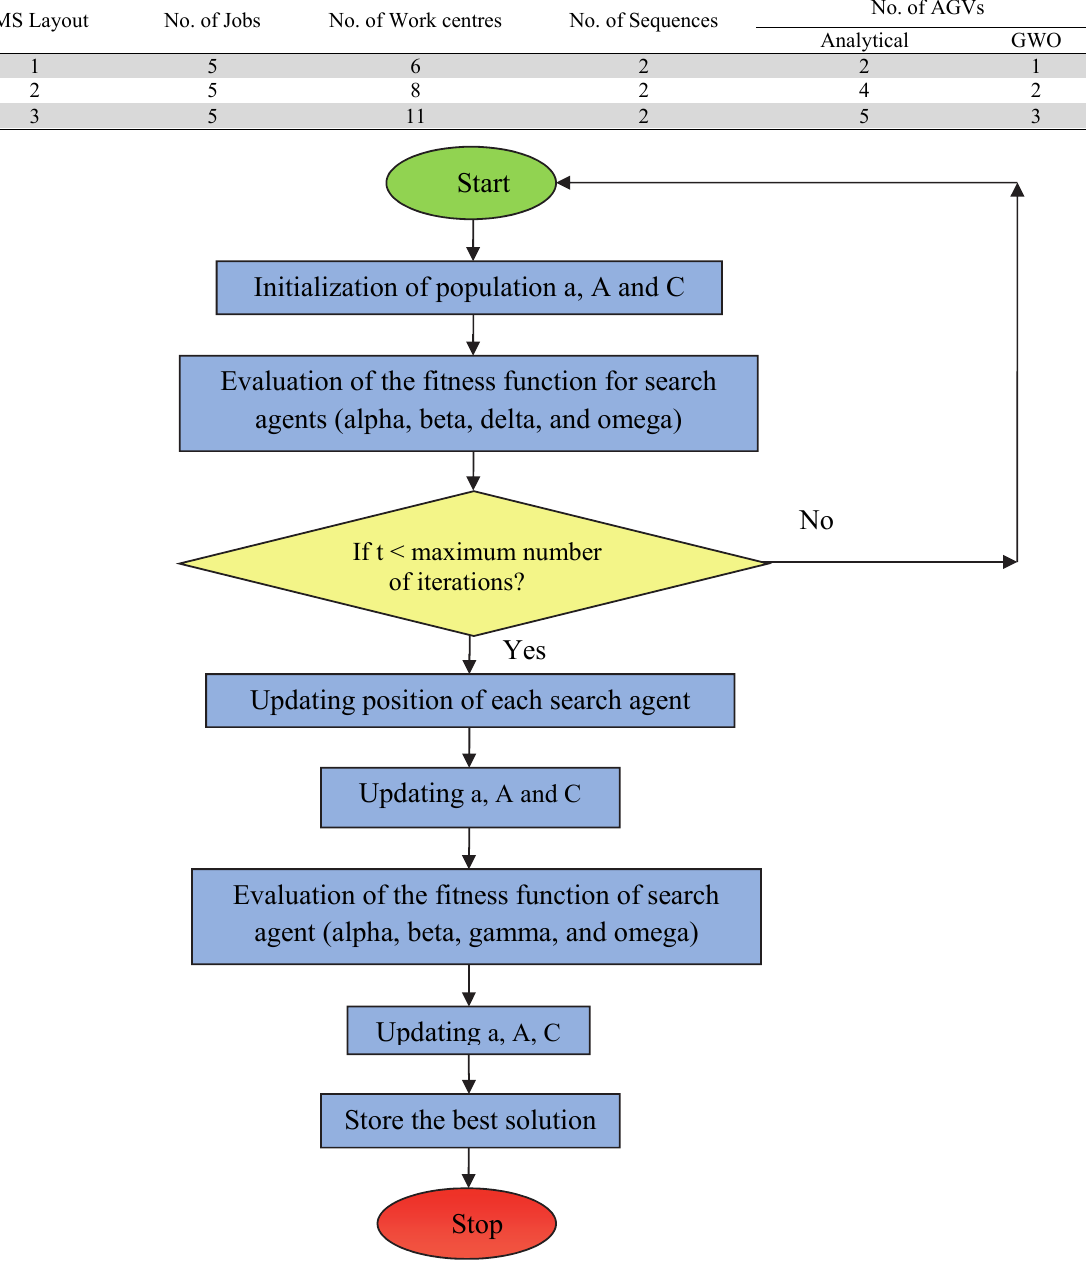
Result comparison of analytical model and grey wolf optimization algorithm. FMS Layout